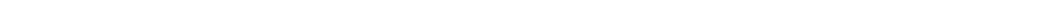
0.001)(See figure on next Fig. 2 Confirmation of the effect of nano‑ and micropatterns for cell behaviors. a FE‑SEM images of PR nanohole patterns and PDMS nanopillar patterns, and b size distribution of PDMS patterns. c 3D SEM image of PDMS nanopillar patterns. d Confocal microscope images of the cells on bare PDMS, and 400, 600, and 800 nm PDMS patterns (left to right) immunostained with actin (Red) and Hoechst (Blue). e ( e ), circularity ( f ), and cell aspect ratio ( g ) of the cells on bare PDMS, and 400, 600, and 800 nm PDMS pattern. h FE‑SEM images of micropatterned silicon wafer, PDMS and side view image of micropatterned PDMS. i Confocal microscope images of the cells on bare PDMS and micropatterned PDMS immunostained with actin (Red) and Hoechst (Blue). j Cell orientation analysis of the cells on the bare PDMS and micropatterned PDMS. (*** p ≤